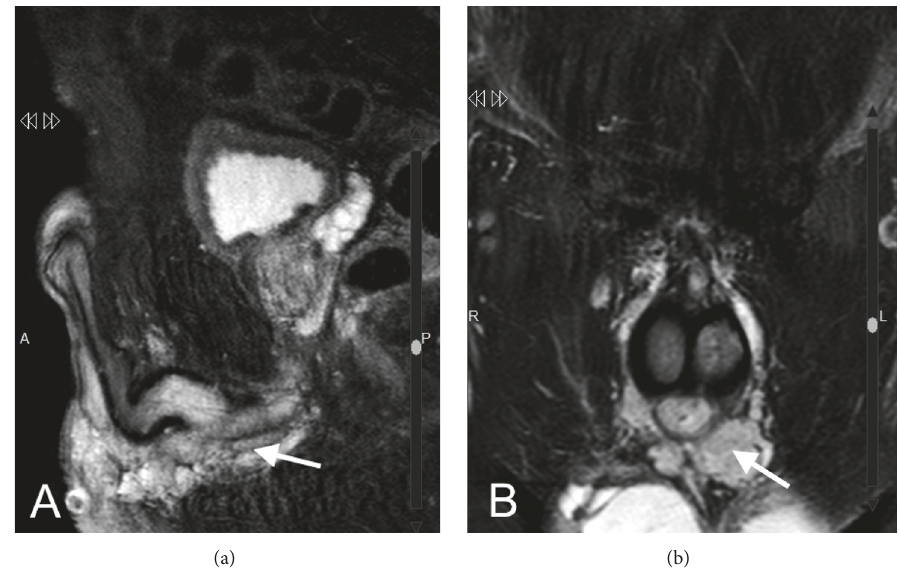
Figure 4: MRI images in T2 sequence, showing periurethral hemangioma. (a) Sagittal section. (b) Coronal